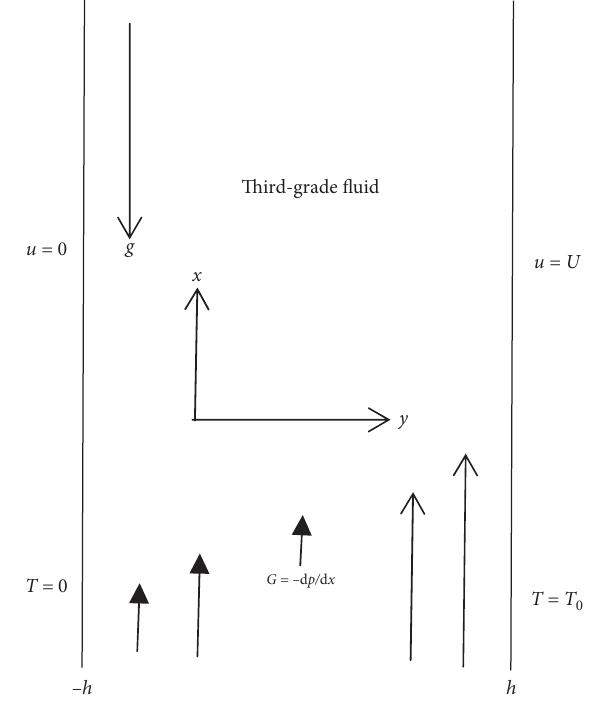
Figure 1: Flow schematic